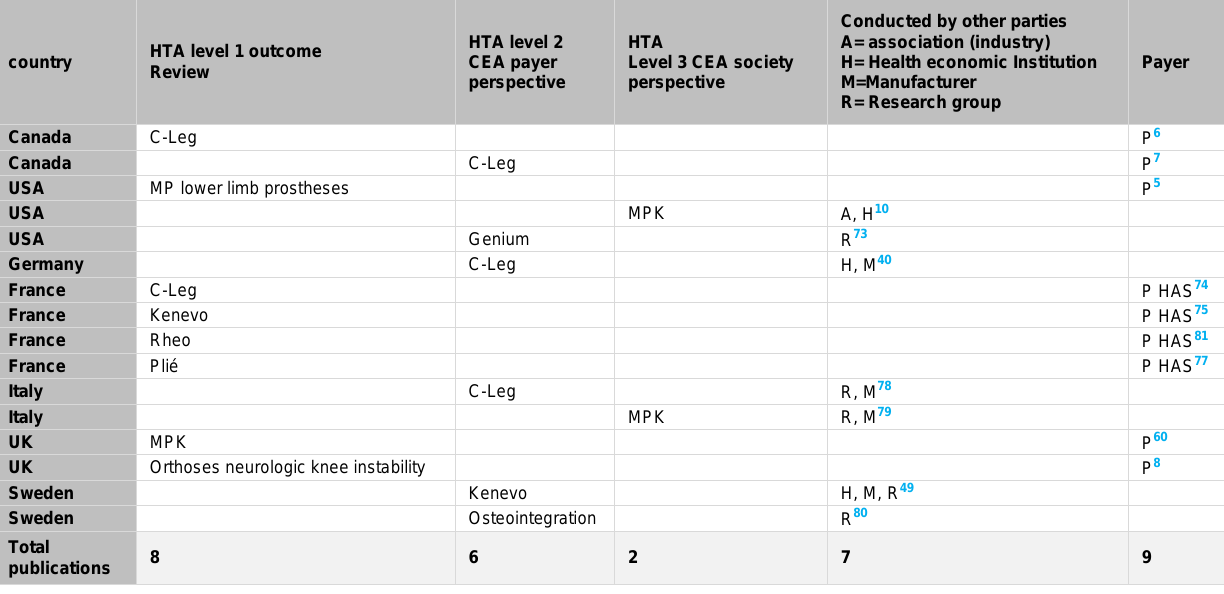
Table 1 : Overview health technology assessment activities performed.